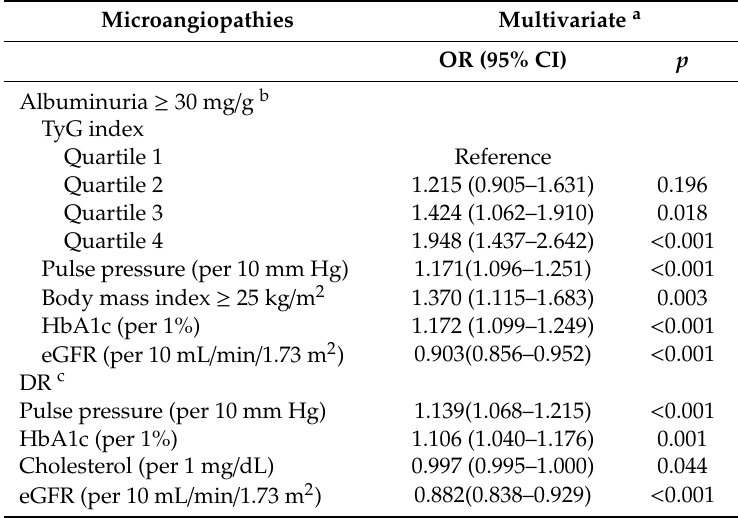
Table 2. Determinants of Microangiopathies Using Forward Binary Logistic Regression Analysis a .